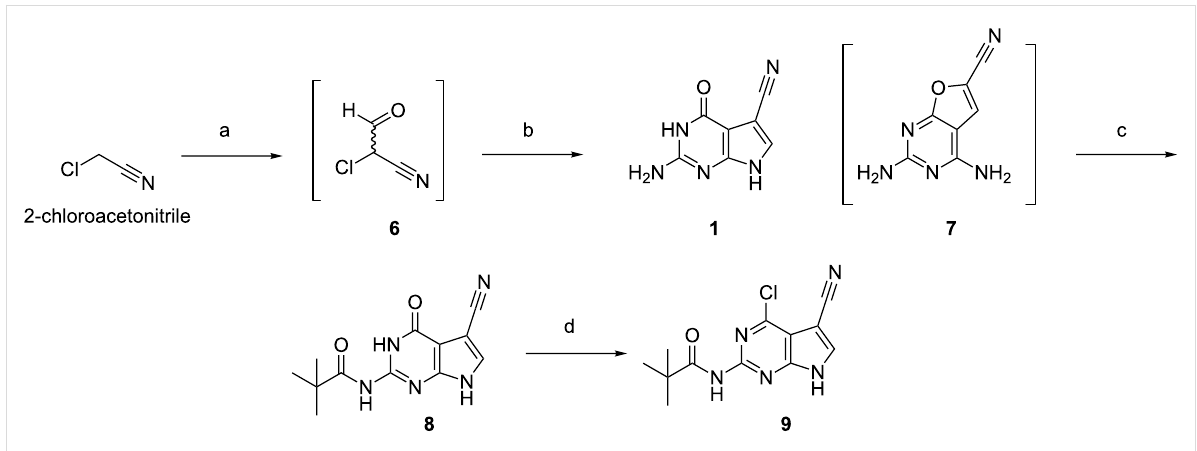
Figure 3: Synthesis of PreQ 0 and chloro-intermediate 9 . Reagents and conditions: (a) Methyl formate, NaOMe, PhMe, 3 h, 0 °C; (b) 2,6-diamino- pyrimidin-4(3 H )-one, NaOAc, H 2 O, 17 h, 100 °C, 60% (over two steps); (c) PivCl, pyridine, 2 h, 85 °C, 64%; (d) POCl 3 , DMA, BnEt 3 NCl, MeCN, 1 h, 90 °C, 35%.